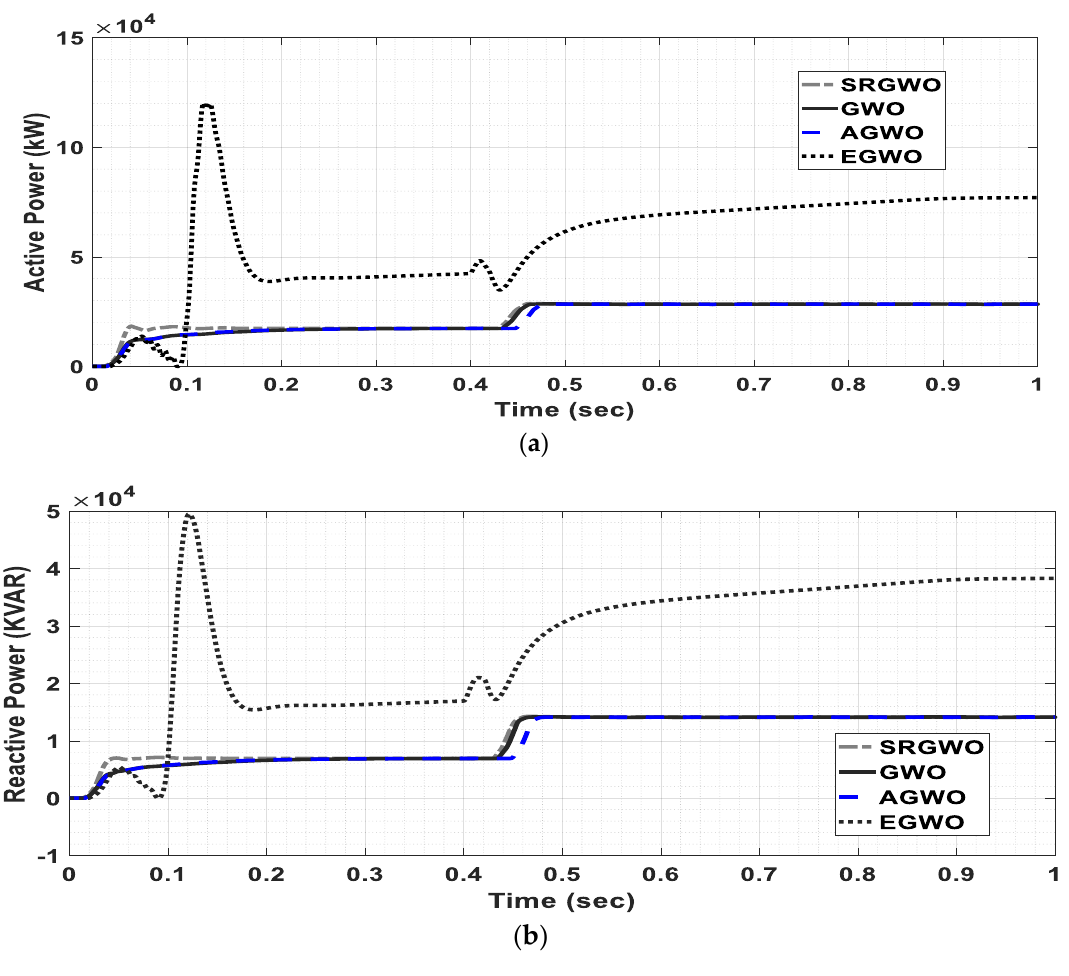
Figure 7. ( a , b ) The comparison of SRGWO with AGWO-, EGWO-, and GWO-based controllers ( a ) Active Power ( b ) Reactive Power.